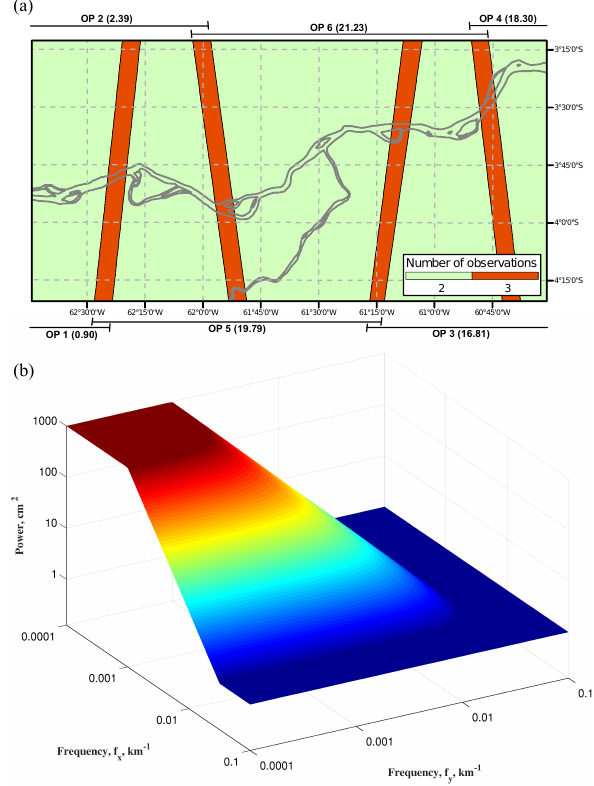
Figure 3. (a) Spatio-temporal sampling for a given cycle, including overpass timings (days from cycle start) during each 22-day cycle; (b) 2-D SWOT science requirements height error spectrum.